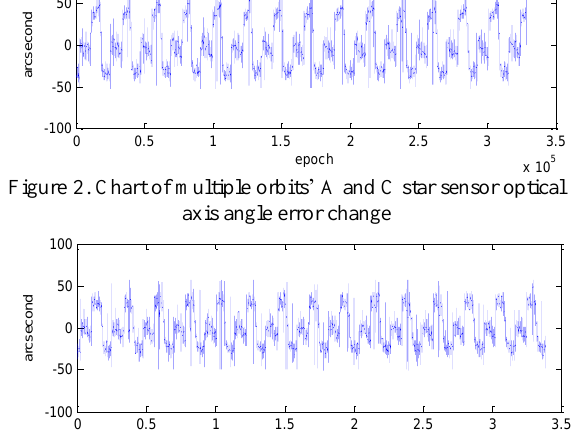
Figure 3. Chart of multiple orbits’ B and C star sensor optical axis angle error change